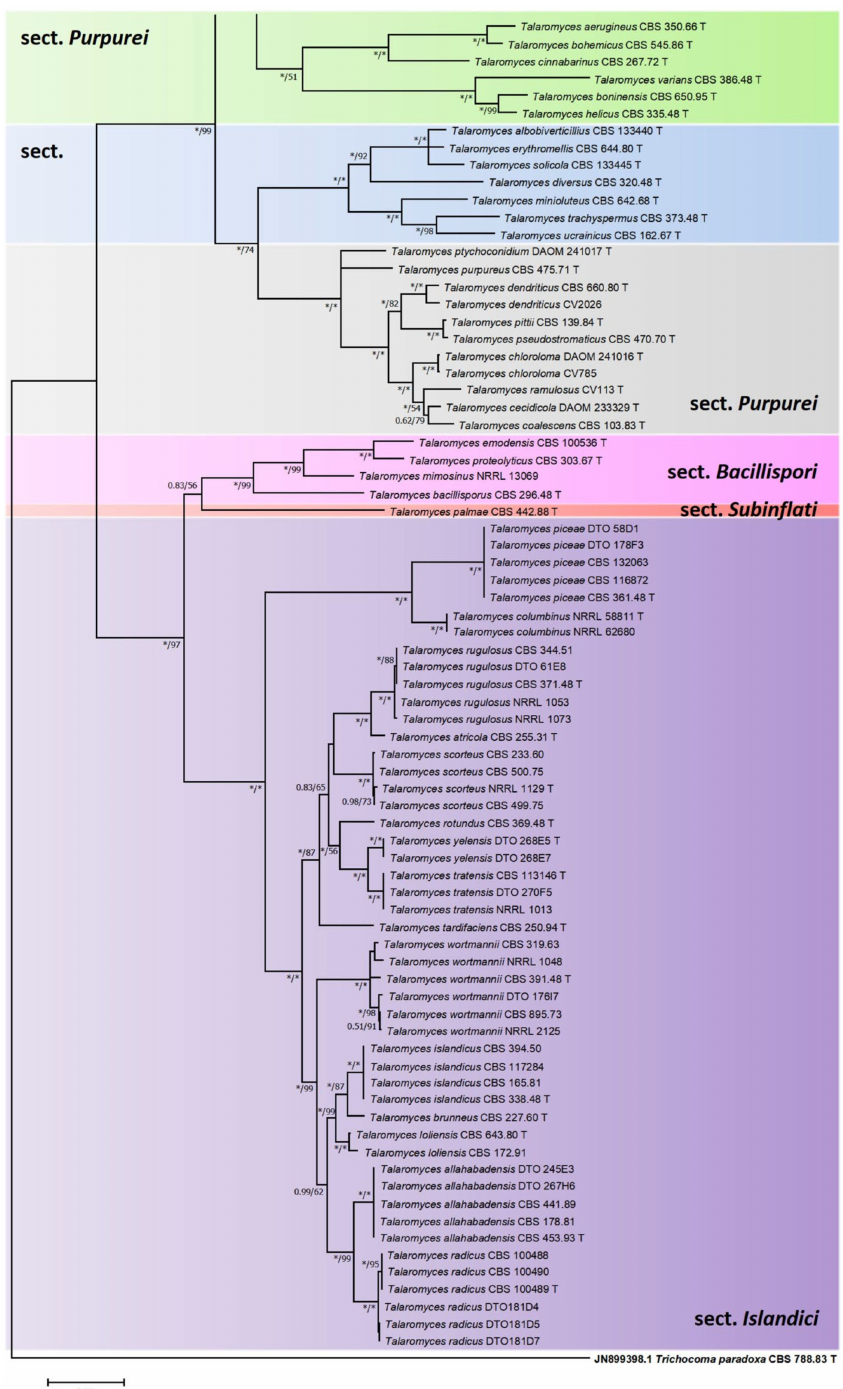
Figure 2. Combined phylogeny of the ITS, BenA , CaM , and RPB2 gene regions of species from Talaromyces . Maximum likelihood tree of strain JP-NJ4 was constructed. Trichocoma paradoxa (CBS_788.83_T) was chosen as out-group. Support in nodes is indicated above branches and is represented by posterior probabilities (BI analysis) and bootstrap values (ML analysis). Full support (1.00/100%) is indicated with an asterisk (*). Bootstrap values lower than 50 is hidden. Best-fit model of Bayesian Inference phylogeny according to BIC: SYM+I+G4; best-fit model of Maximum likelihood phylogeny according to AIC: Kimura 2-parameter (K2) +G+I; alignment, 439 (ITS) + 284 ( BenA ) + 482 ( CaM ) + 677 ( RPB2 ) = 1882 bp. Scale bar: 0.05 substitutions per nucleotide position. T indicates ex type. The strain with red font is the strain JP-NJ4 to be